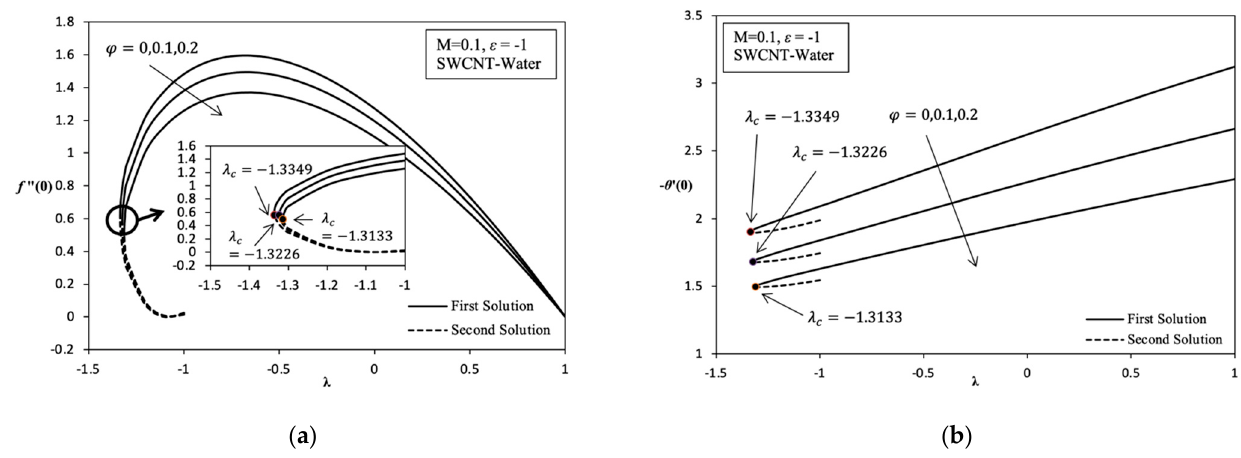
Figure 2. Variation on 𝜆 with various values of 𝜑 in SWCNT-water when M = 0.1 and 𝜀 = −1 : ( a ) Variation on f ″ (0); ( b ) Variation on − 𝜃 ′ (0).